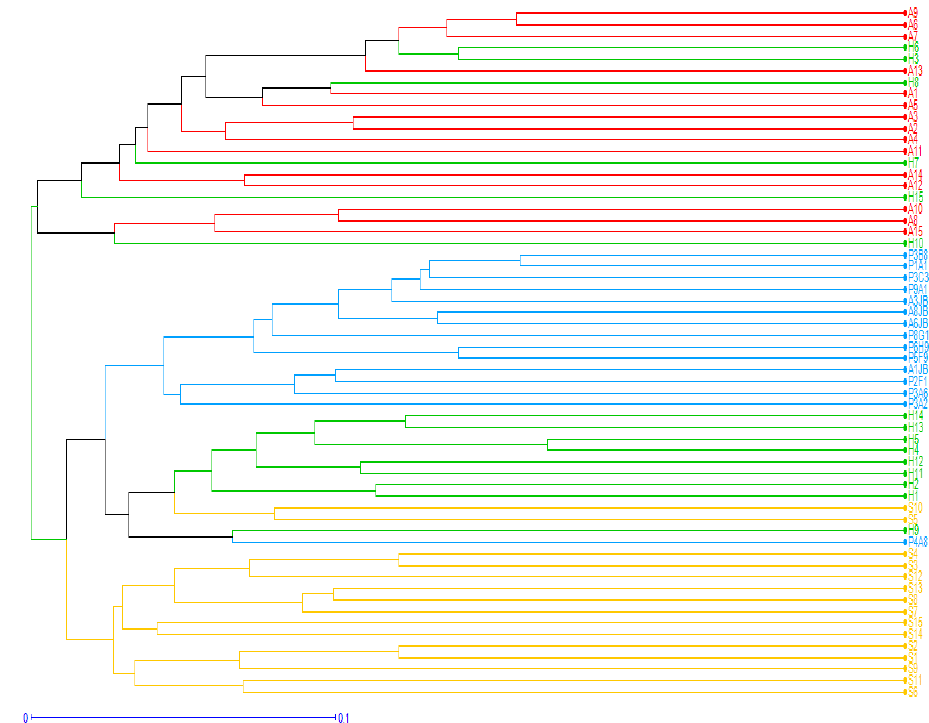
Figure 4. Dendrogram generated by UPGMA clustering analysis using the genetic distance matrix data with 10 ISSR markers, showing the relationship among the four populations of A. spinosa . Constructed with Darwin software (boostrap 1000).